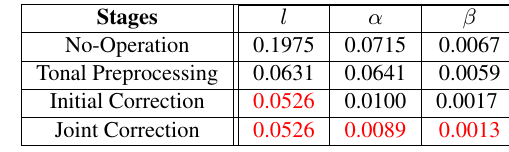
Table 3. Average tonal differences in l , (cid:11) and (cid:12) channels after different processing stages for real multi-temporal images shown in Figure